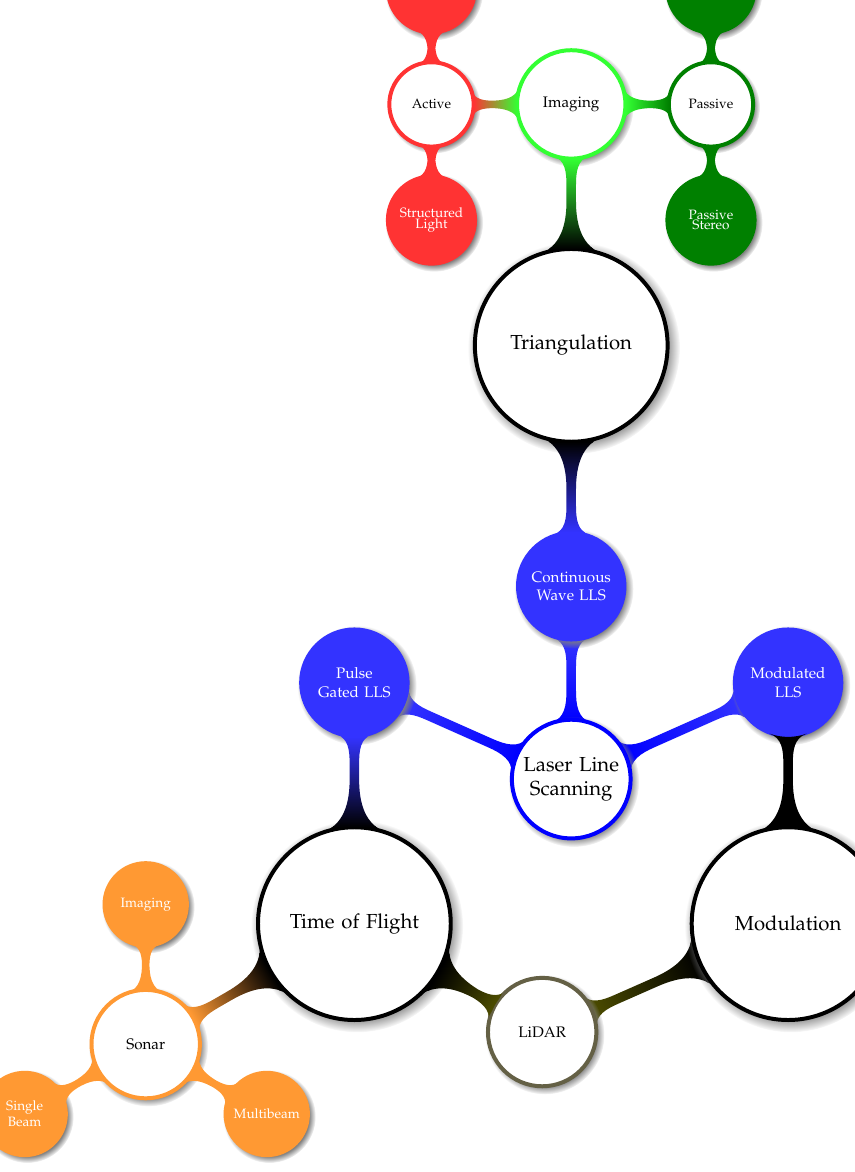
Figure 2. 3D reconstruction sensor